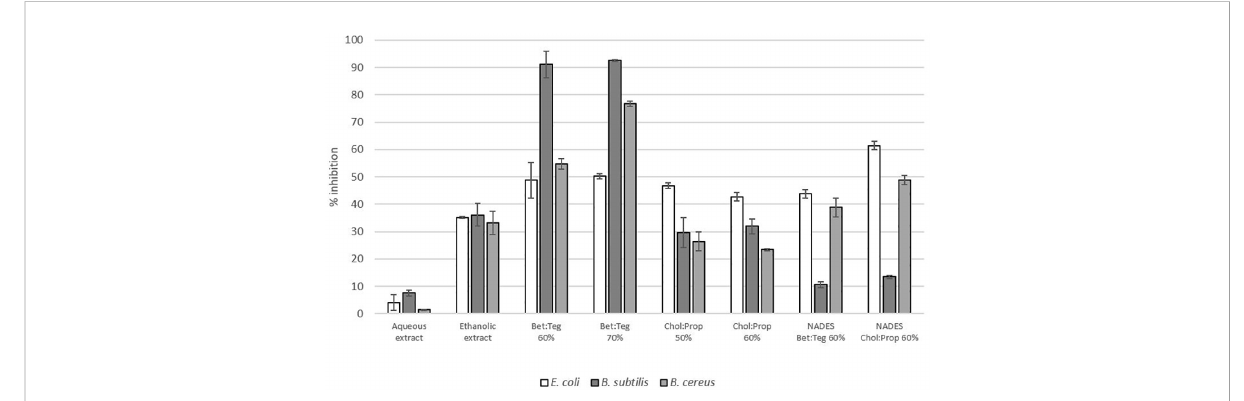
FIGURE 5 Inhibitory activity (%) of the extracts at the highest dilution and the corresponding solvents alone at the same dilution for Chol : Prop 60% and Bet : TEG 60%; the total polyphenol concentration (GAE mg/ml) in each extract was as follows: 830 (aqueous), 838 (ethanolic), 153 (Chol : Prop 50%), 141 (Chol : Prop 60%), 101 (Bet : TEG 70%), and 148 (Bet : TEG